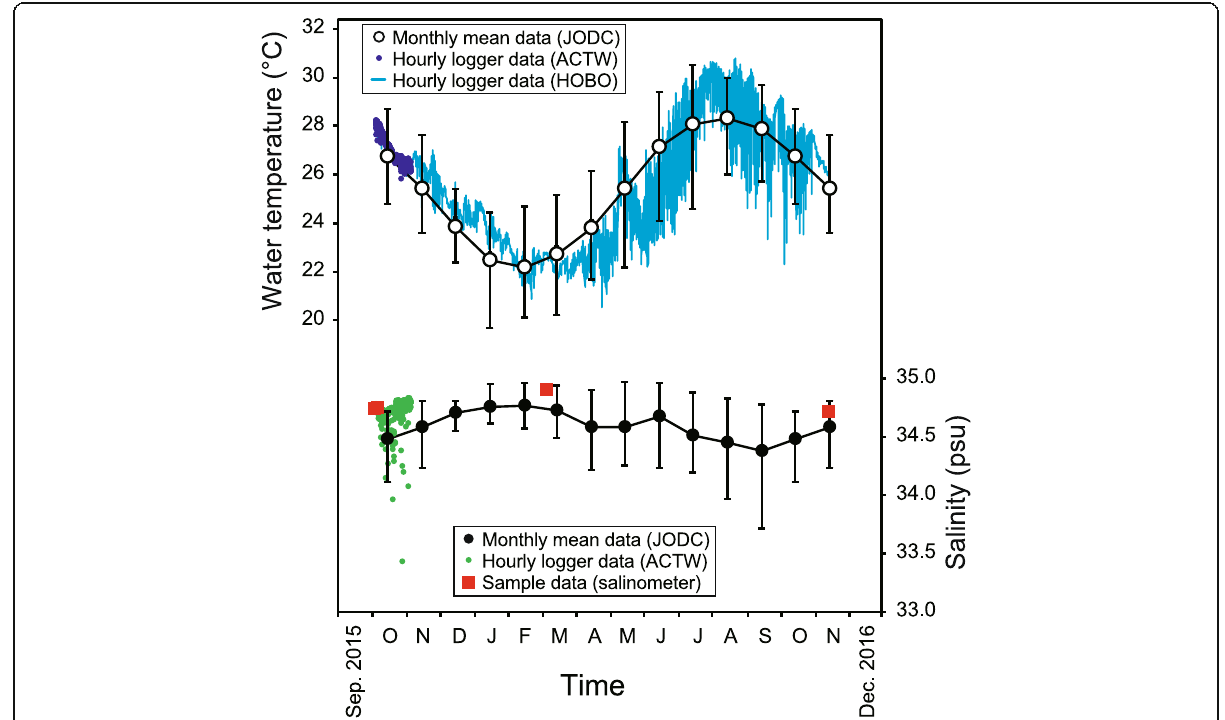
Fig. 2 Monthly mean climatology and logging data of seawater temperature and salinity at the study site. Data are derived from the Japan Oceanographic Data Center (JODC) for 1906 – 2003 (26° – 27° N, 126° – 127° E; http://www.jodc.go.jp/) and in situ observations made during October 2015 to November 2016 using loggers in this study. Error bars represent monthly maximum and minimum values in the past. Salinity of seawater samples collected at the site was also measured for